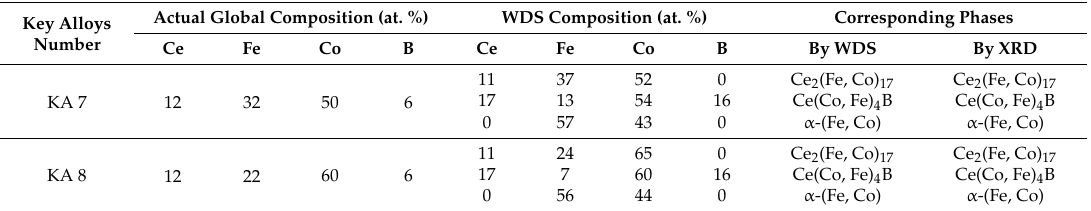
Two phases formed in KA 1 (Ce 14 Fe 73 Co 7 B 6 ) after annealing at 900 °C for 25 days, as shown in Figure 12a. The solid solubility of the dominating Ce 2 (Fe, Co) 14 B was measured as 6 at. % Co. A boron-rich compound (Ce 13 Fe 39 Co 3 B 45 ) with similar chemical composition, which is found in the diffusion-couple study, is also observed in this key alloy. From the MFM test, as presented in Figure 12b, dominating stripe magnetic domain patterns with some dispersed non-magnetic plates were observed. Comparing the phase morphology between SEM and MFM images, it is concluded that the dominating Ce 2 (Fe, Co) 14 B phase is magnetic, and non-magnetic regions belong to Ce 13 Fe 39 Co 3 B 45 . In Figure 12c, Ce 2 (Fe, Co) 14 B is positively identified in the XRD pattern of KA 1. However, the crystal structure prototype of Ce 13 Fe 39 Co 3 B 45 has not been reported, hence this compound cannot be verified by XRD analysis. A number of unlabeled peaks, marked by “?” in Figure 12c, may belong to Ce 13 Fe 39 Co 3 B 45 .